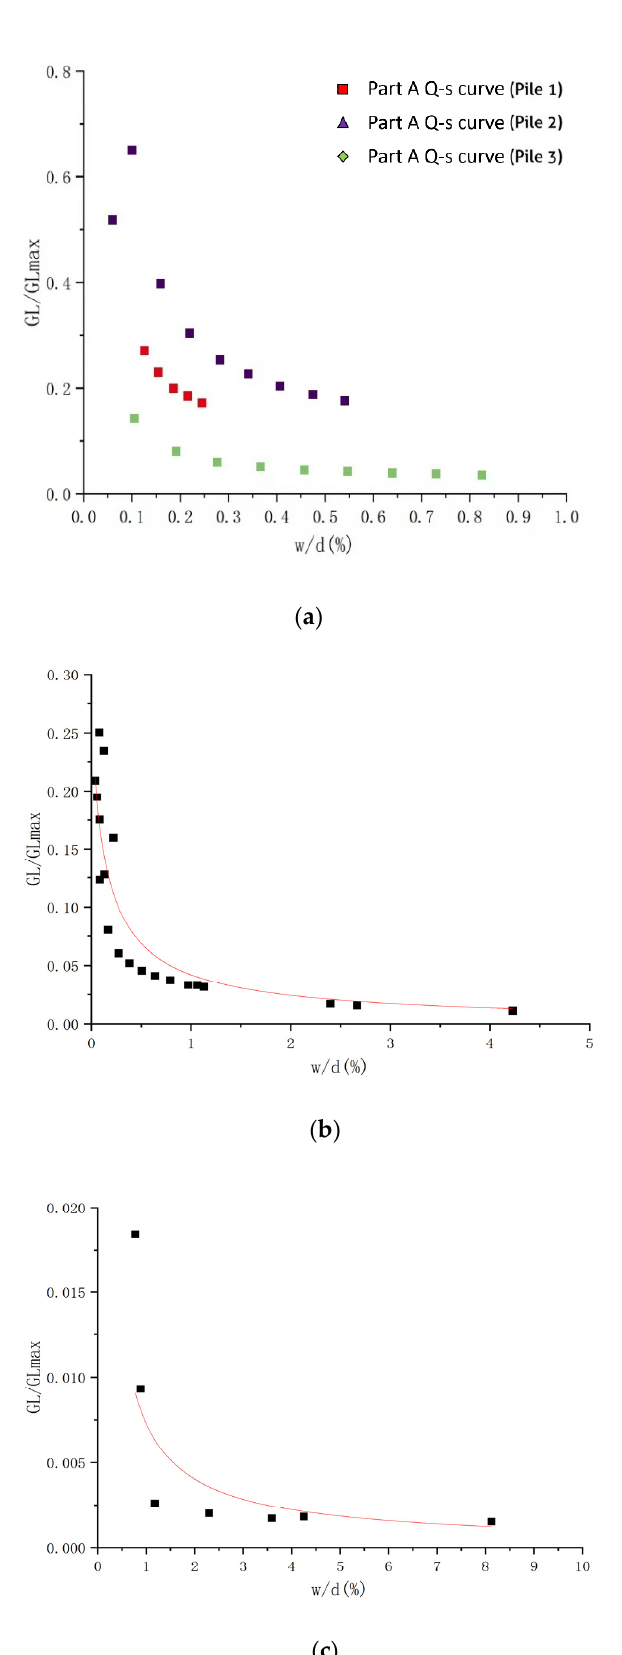
Figure 11. Modulus reduction factor ( G L / G Lmax ) versus per cent pseudo-strain ( w / d [%]) for ( a ) upper part, ( b ) middle part and ( c ) lower part.